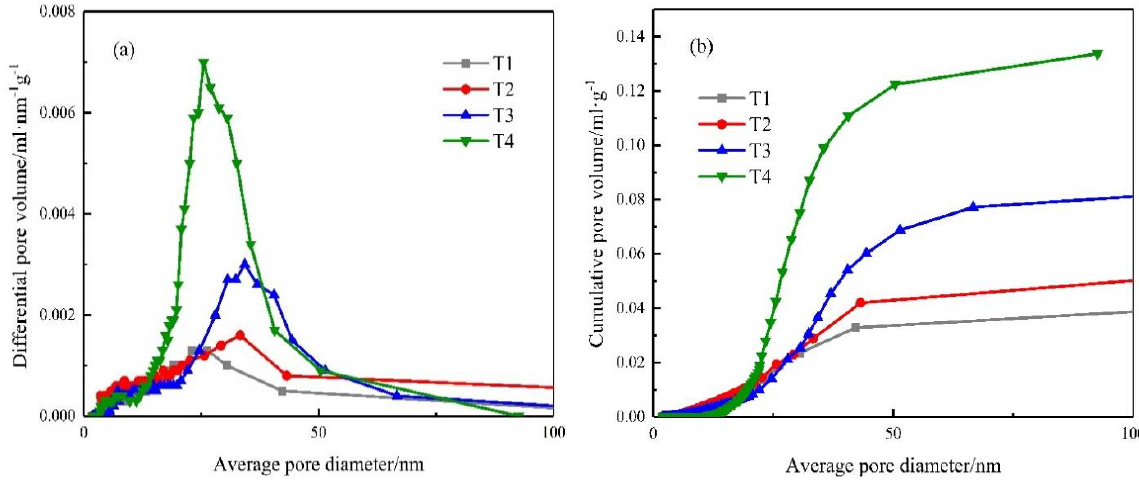
Figure 9. BET analysis of UHPC repair materials: ( a ) differential pore volume, ( b ) cumulative pore volume.